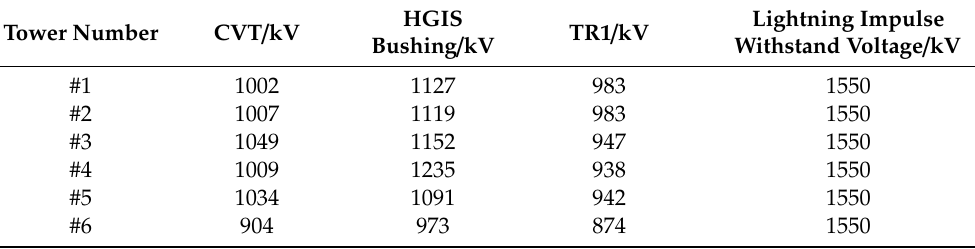
Table 12. Maximum voltage of the equipment when the two-column arrester is